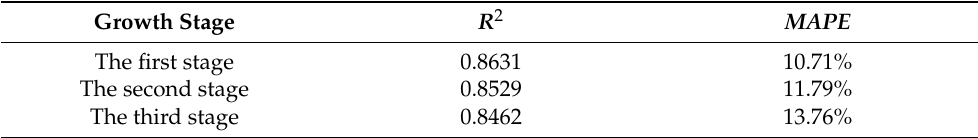
Table 15. R 2 and MAPE for the linear regression fresh weight Table 15. 𝑅 2 and 𝑀𝐴𝑃𝐸 for the linear regression fresh weight model.